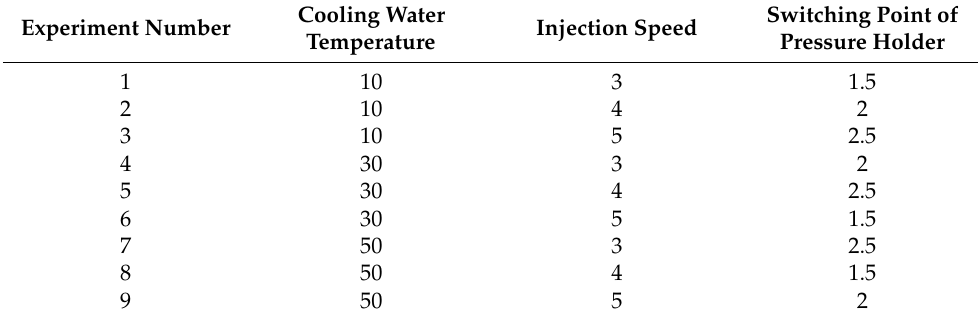
Table 3. The experimental settings.